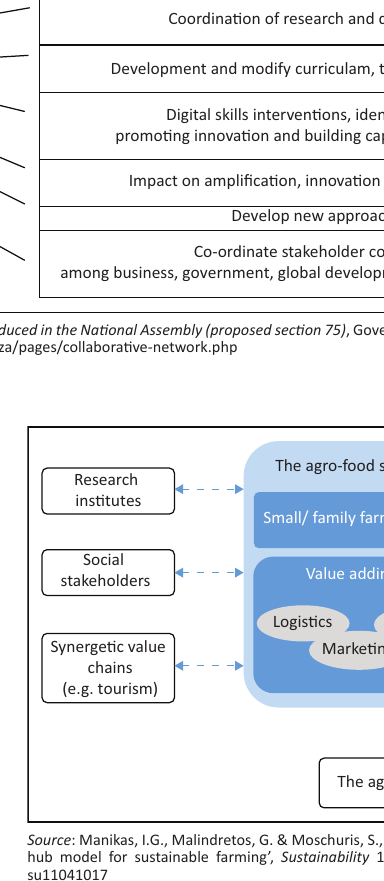
FIGURE 8: A holistic integrated Agro-Food Sustainability Knowledge